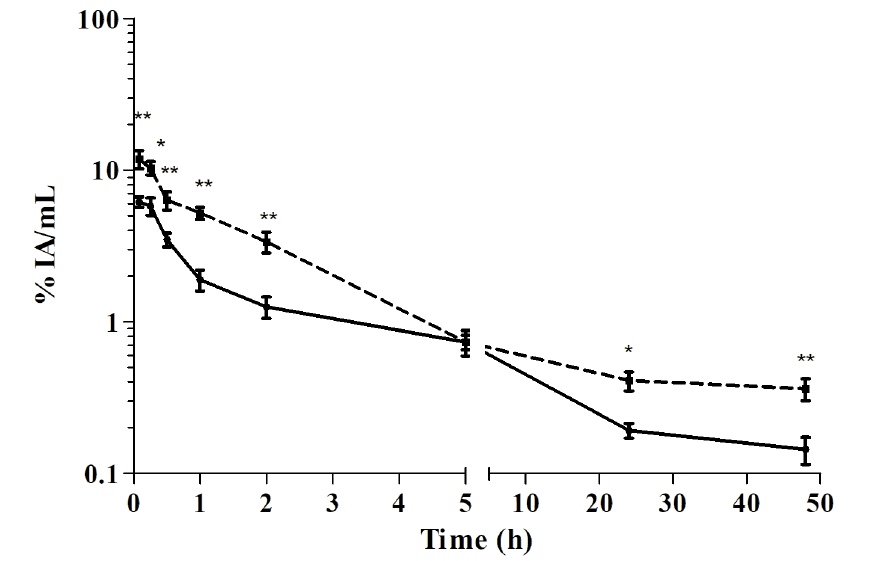
Figure 4 Blood pharmacokinetics of antimony in uninfected [22] and L. ( L. ) amazonensis -infected BALB/c mice after intraperitoneal administration of meglumine antimoniate. Continuous line: infected mice; dotted line: uninfected mice. Data are expressed as the mean ± standard deviation (n= 5/time) of the percentage of injected activity (IA) per milliliter of blood. The significance of differences between uninfected and infected mice was calculated by Student’s t test. * p < 0.05 and ** p <